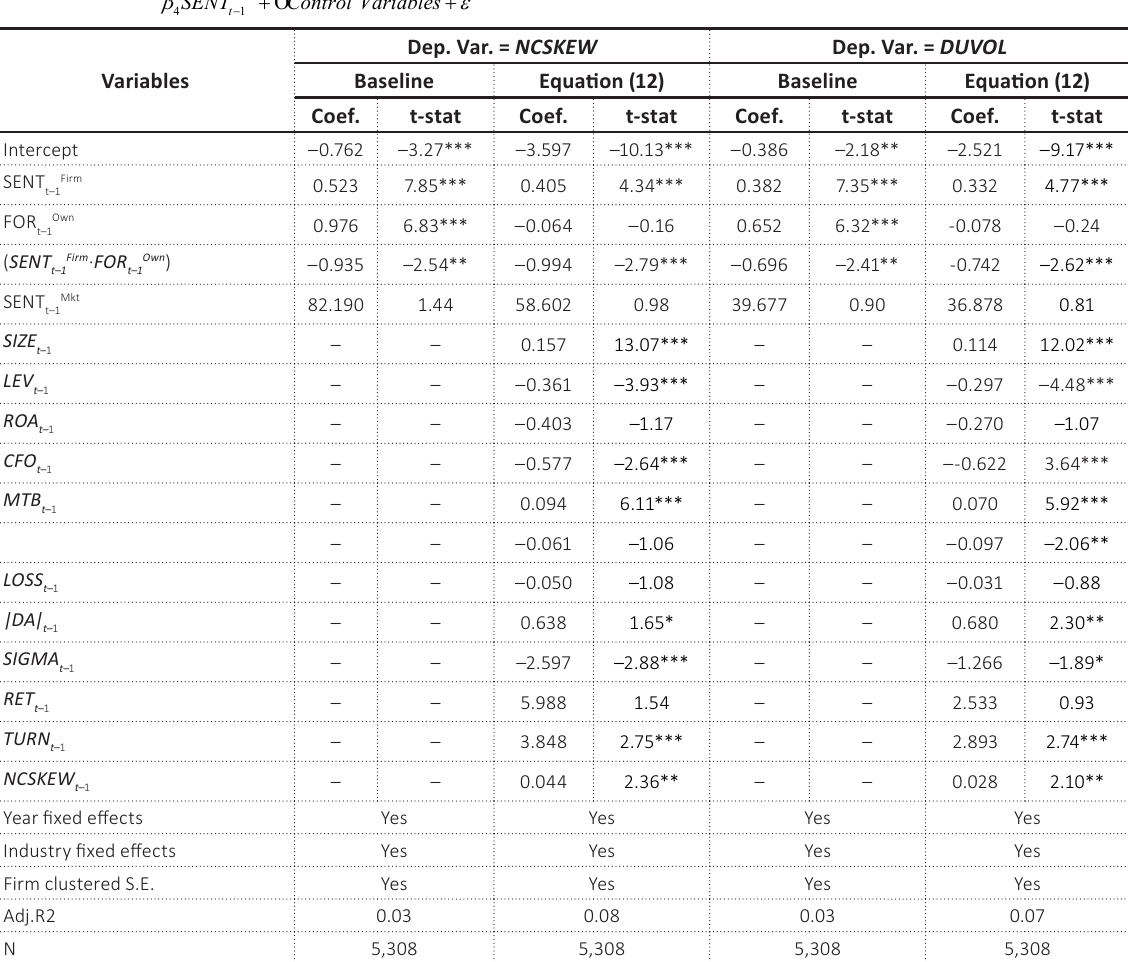
Table B3. The effect of firm-specific investor sentiment on stock price crash risk: The role of foreign